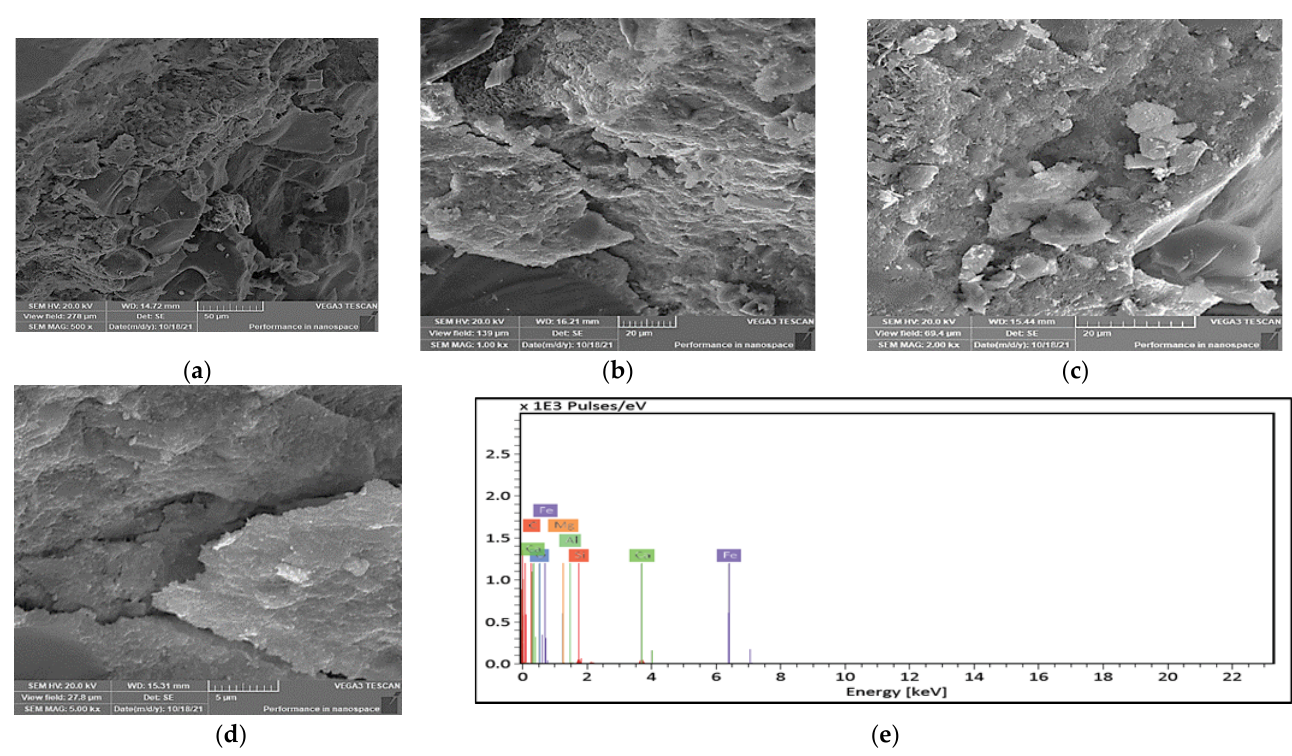
Figure 16. SEM with various magnification factors ( a – d ); ( e ) EDX for the mix UHPSCC 7 at (150 °C) temperature.